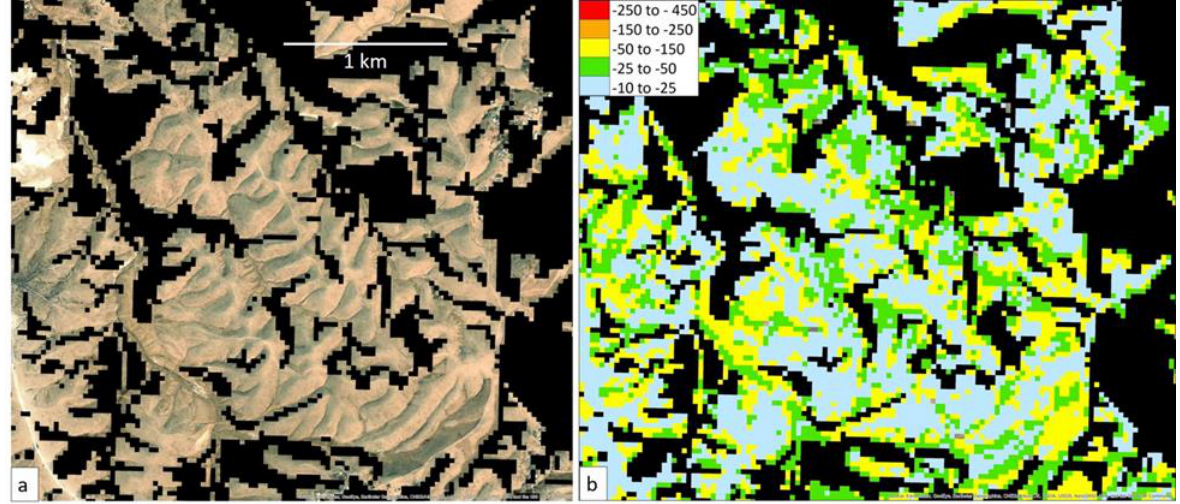
◦ 10.68 (cid:48) N, 34 ◦ 51.84 (cid:48) E). ( a ) True color image; ( b ) LNS